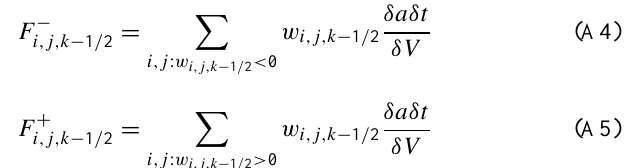
nents together thereby losing spatial variability in the